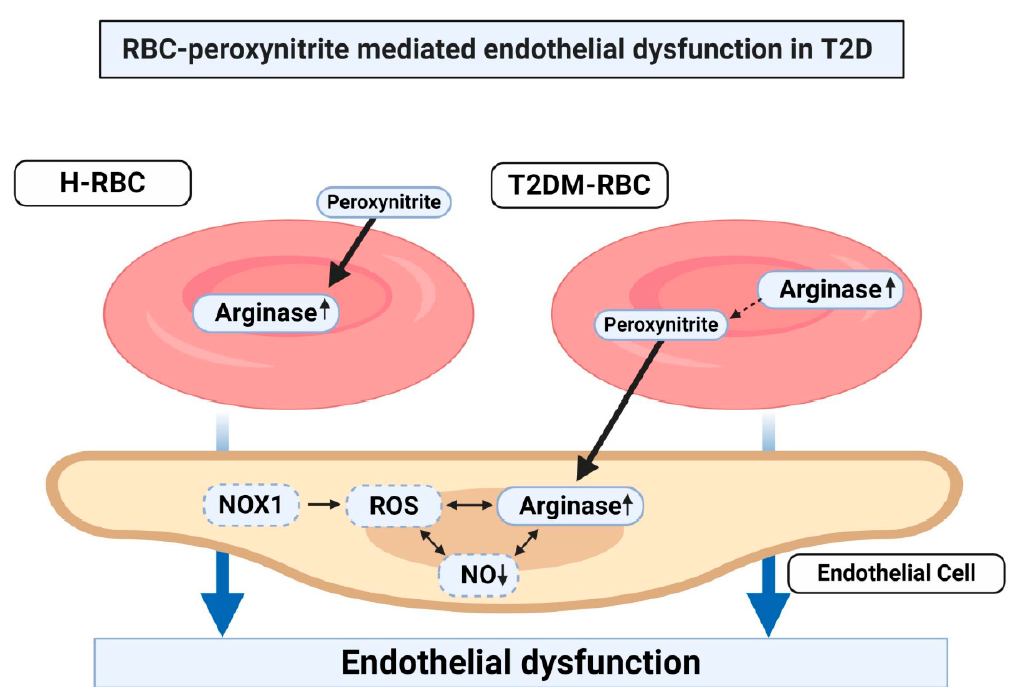
Figure 4. Central illustration. Peroxynitrite up-regulates arginase activity in red blood cells (RBCs) from healthy subjects (H-RBC) which induces endothelial dysfunction. Moreover, scavenging of peroxynitrite in RBCs from patients with T2DM (T2DM-RBCs) prevents endothelial dysfunction via prevention of up-regulation of arginase in endothelial cells. Dashed boxes represents earlier findings of ours where NADPH oxidase 1 (NOX1) represents a major source of reactive oxygen species (ROS), consequently resulting in the down-regulation of nitric oxide (NO) [3].